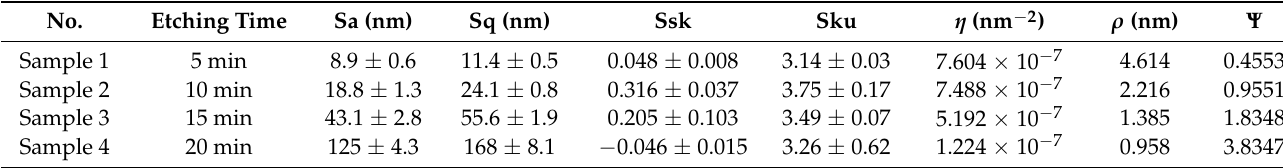
Table 5. Roughness parameters of